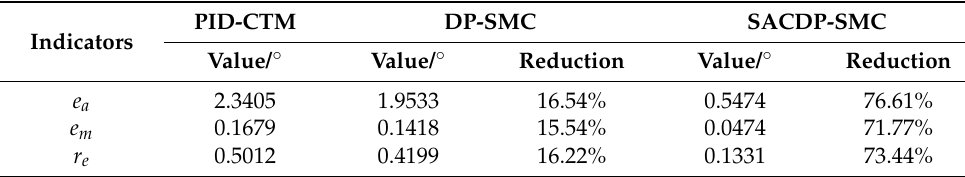
Table 4. The metrics of control accuracy.